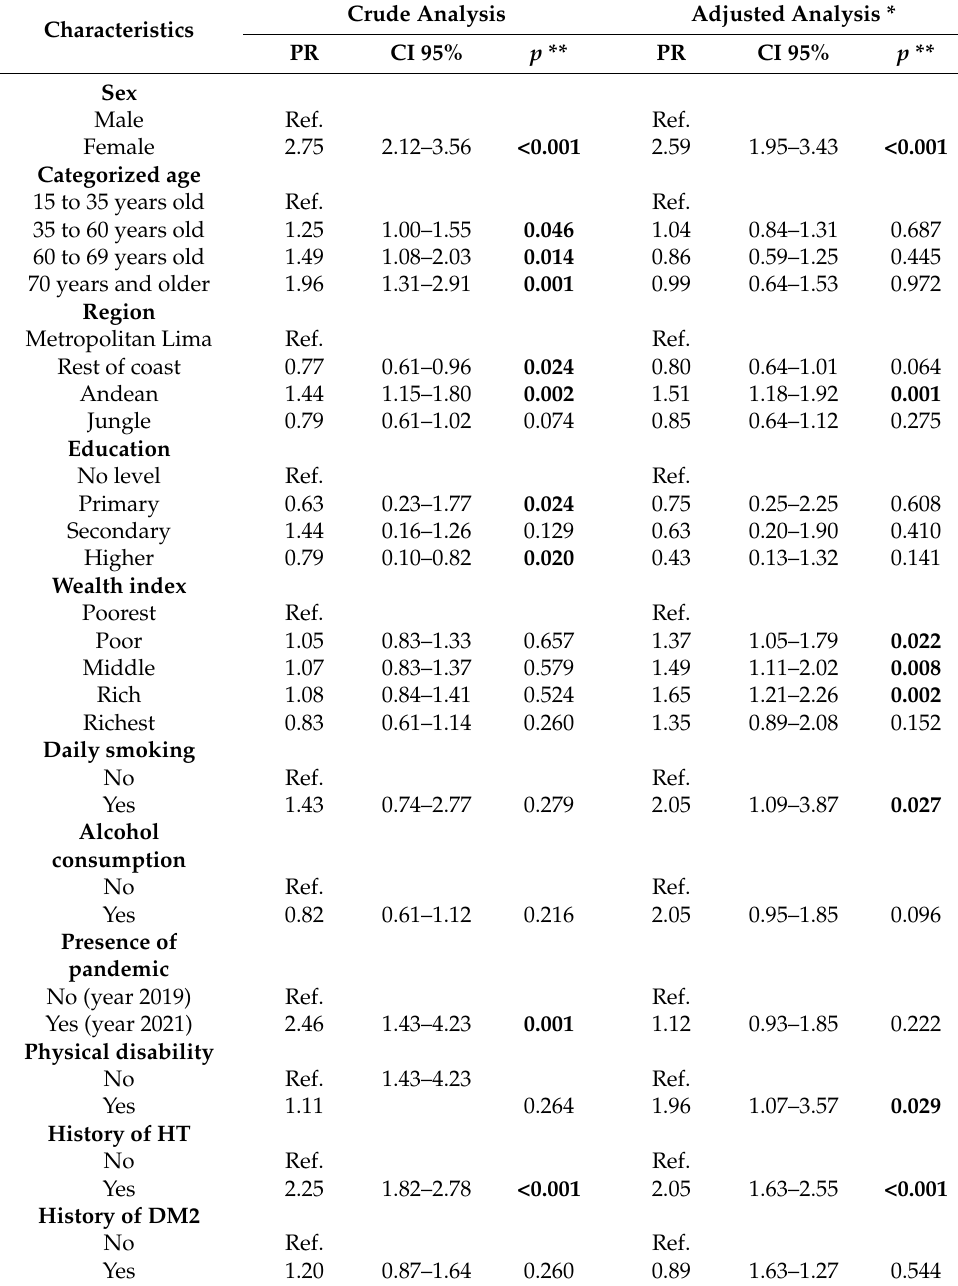
Table 3. Adjusted simple multivariate regression analysis of factors associated with depressive symptoms in patients with